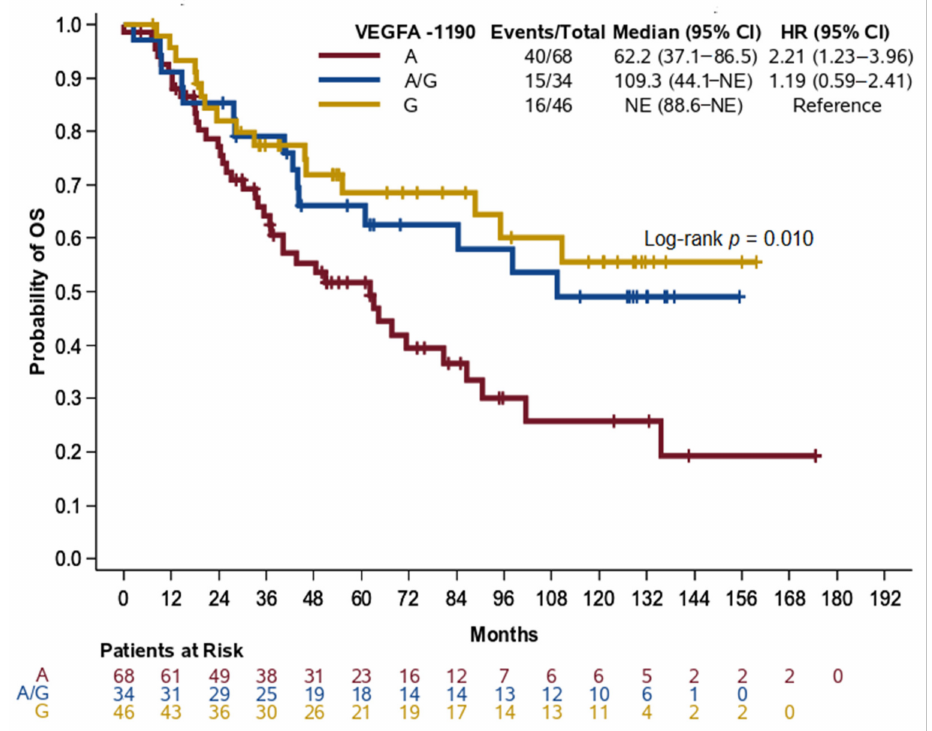
Figure 3. Kaplan–Meier curves for OS according to VEGFA − 1190 genotypes among non-NPC patients. HR: hazard ratio, CI: confidence interval, NE: not